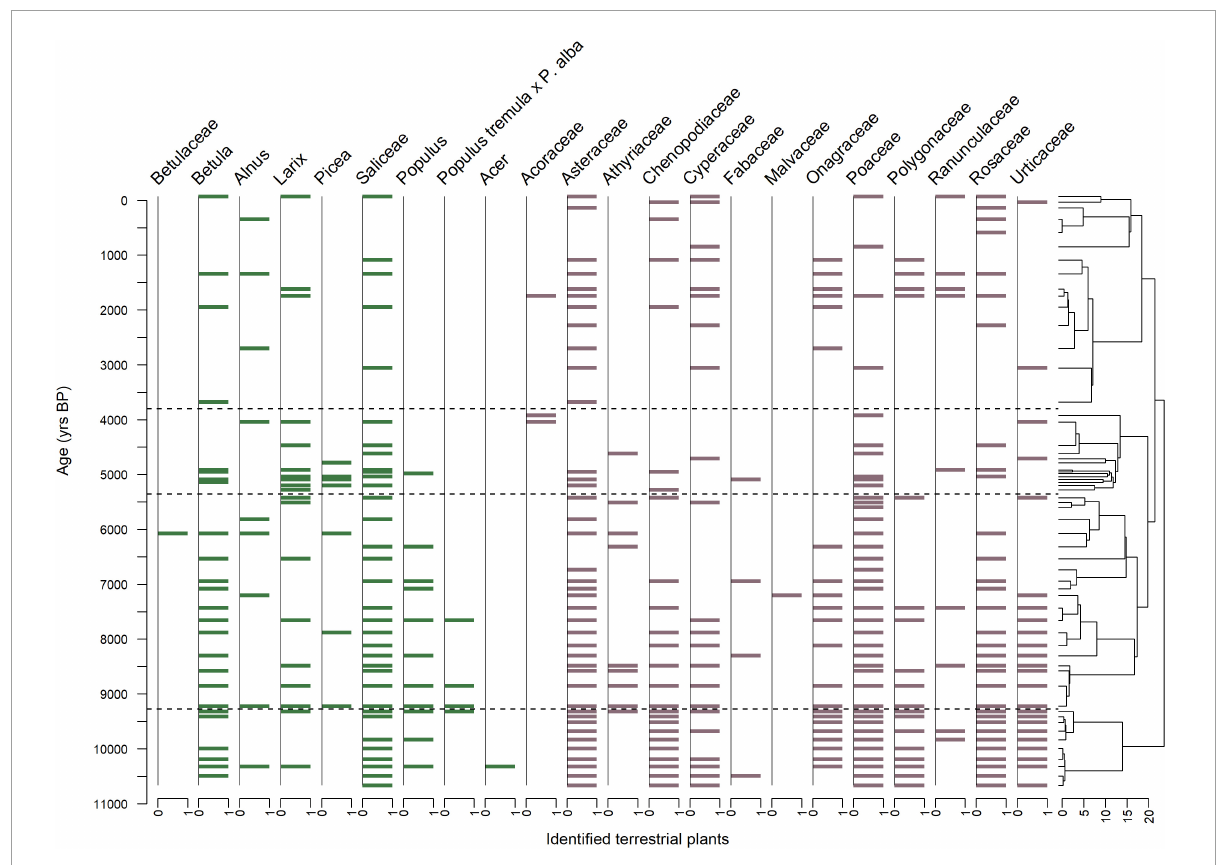
FIGURE7 Sedimentary ancient DNA (sedaDNA) record for terrestrial plants, with zone separations from cluster analysis and displaying the presence or absence of plant types. Typical arboreal families are resolved to show the highest taxonomic level identified, whereas non-arboreal plants are shown on family